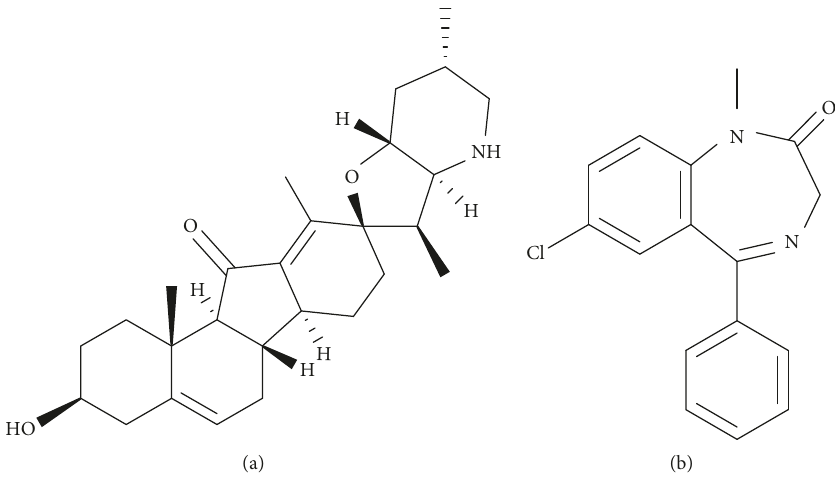
Figure 1: The chemical structure of jervine (a) and diazepam